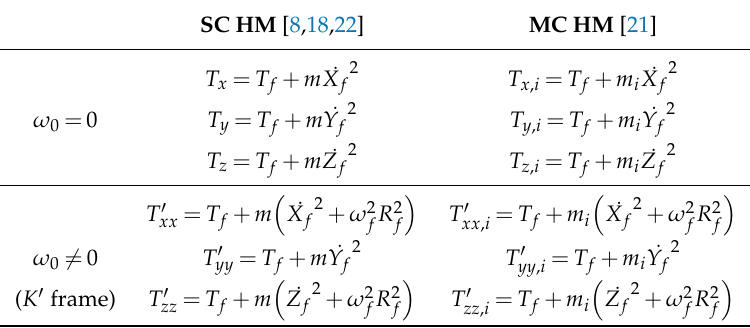
Table 6. The comparison of the inverse slope parameters after kinetic freeze-out at temperature T f , for a Single Component (SC) and for a Multi-Component (MC) Hadronic Matter (HM) from exact and analytic solutions of fireball hydrodynamics, in the case of rotating and nonrotating ellipsoid as well. In the case of non-rotating fireballs, the temperature matrix is diagonal in the center of mass frame K , T kl = diag ( T x , T y , T z ) . For rotating fireballs, the temperature matrix is diagonal only in the co-rotating (cid:48) (cid:48) = diag ( T (cid:48) ) . frame K (cid:48) , where T (cid:48) xx , T yy , T zz kl SC HM [8,18,22] MC HM